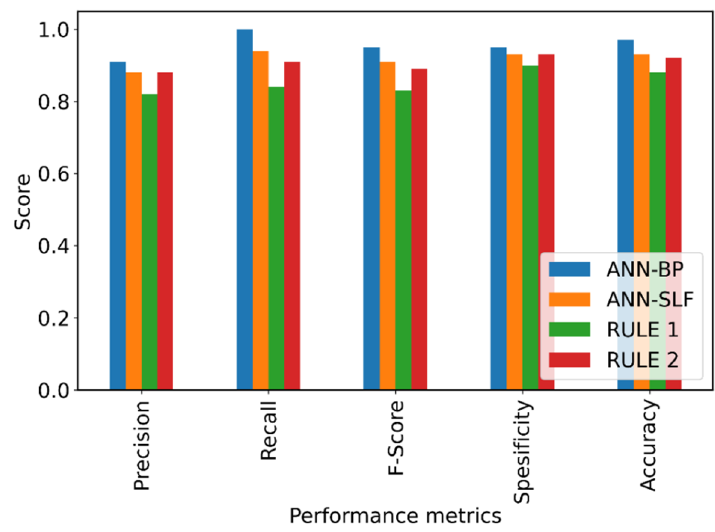
Figure 9. Performance comparison of ANN models and constructed rules.